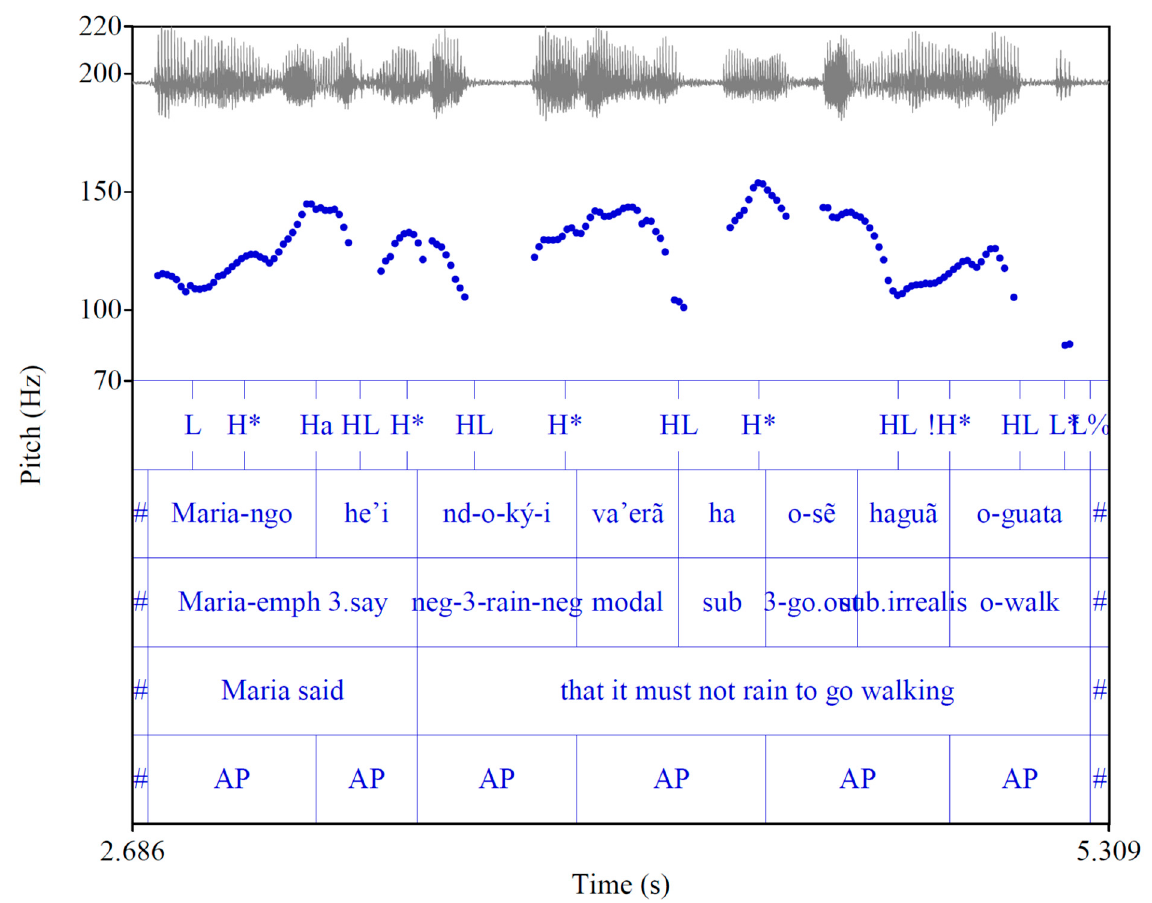
Figure 5. Ndokýi va’erãha os ẽ haguã oguata. Figure 5. Ndok ý i va’er ã ha os ẽ hagu ã